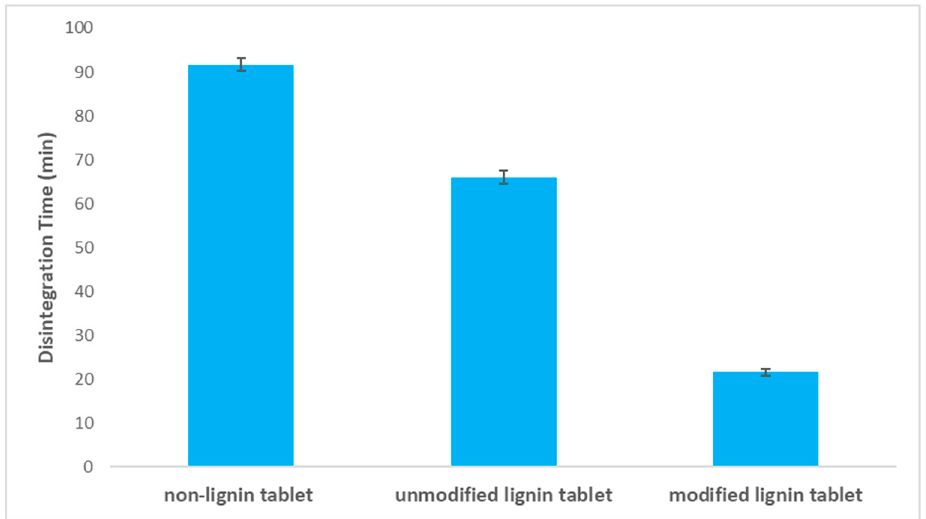
Figure 3. Disintegration time of tablets prepared containing pure lignin, modified lignin and no lignin.